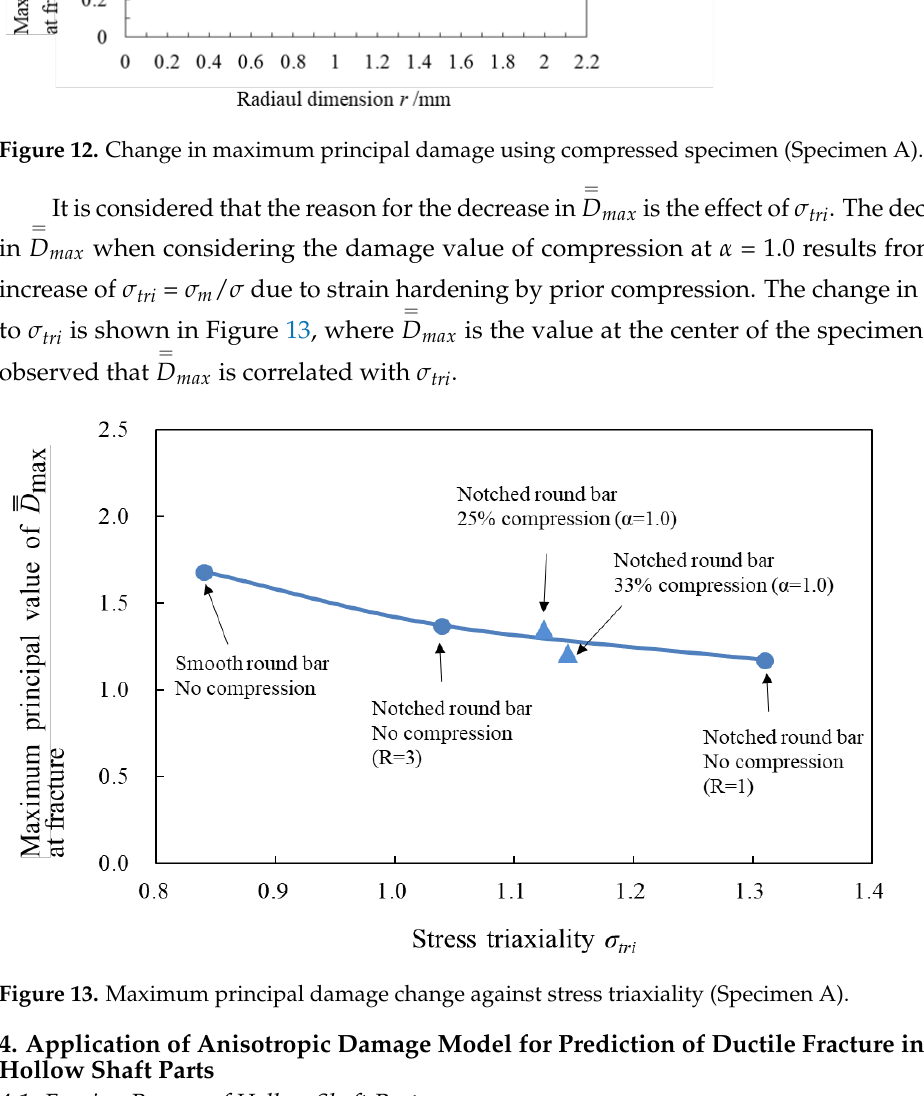
Figure 13. Maximum principal damage change against stress triaxiality (Specimen A).